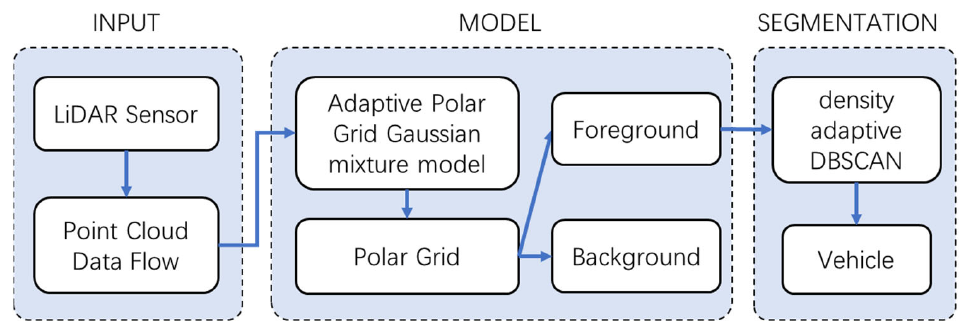
Figure 1. The schematic block diagram of the proposed method.